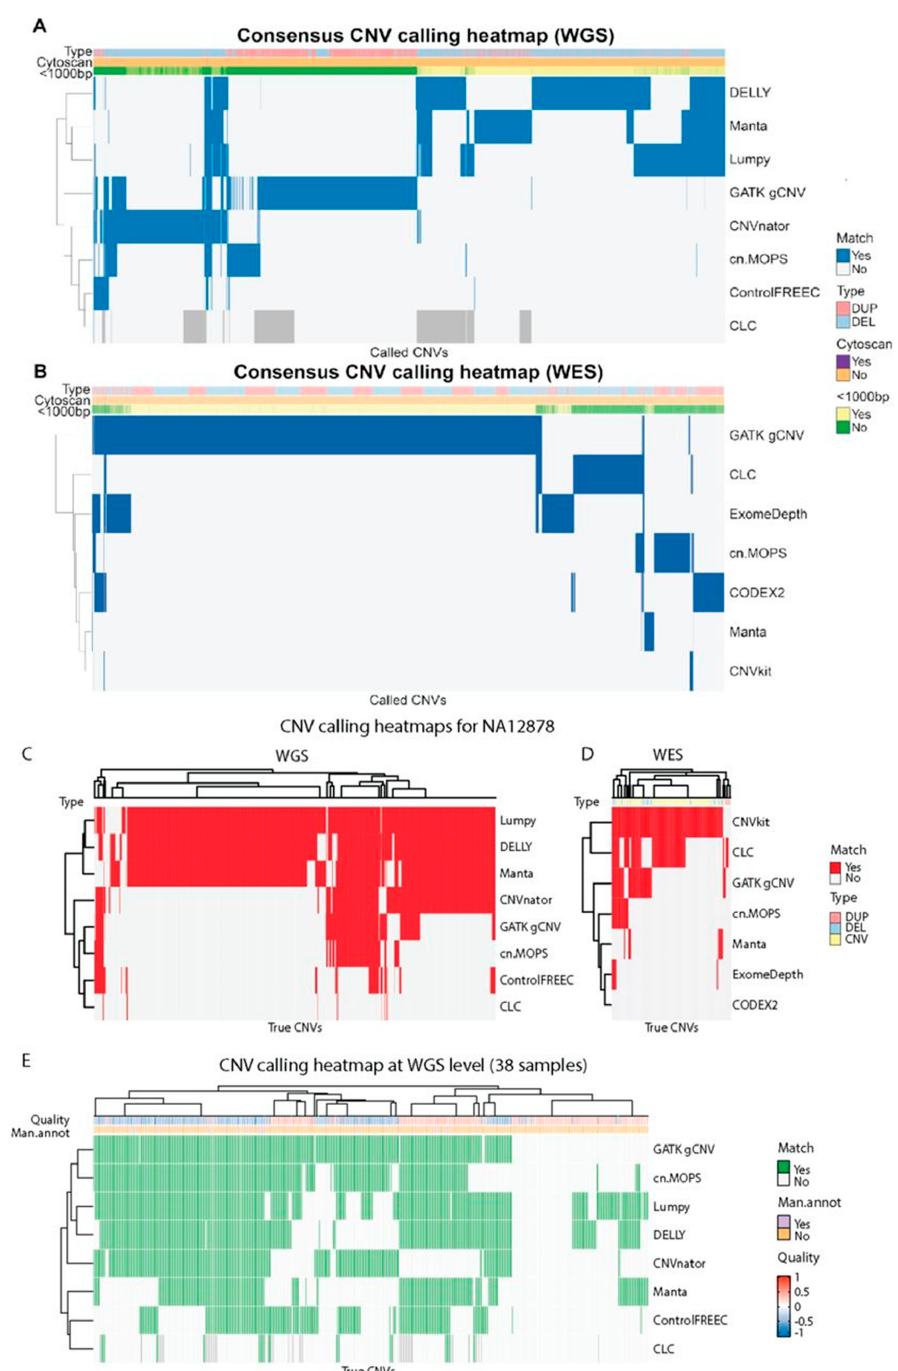
Figure 5. Heatmap showing all called CNVs across all samples ( A , B ) and called CNVs overlap with the true CNVs ( C – E ). ( A ) Whole genome sequencing (WGS; n = 407,671) and ( B ) Whole exome sequencing level (WES; n = 9944). Each row represents a tool, and a blue field denotes a call of the given CNV. All CNVs from each sample were merged across tools, such that any overlapping calls of either duplications or deletions were combined to one. Blue color denotes that the given CNV was called by the tool. The order of rows/columns for WES data and rows for WGS data was determined using complete-linkage hierarchical clustering with Euclidean distance, while the order of columns for WGS data was determined using a combination of k-means and hierarchical clustering due to memory restrictions. Darker grey coloring (WGS only) indicates that the tool was not run for the sample which contained the CNV. ( C ) 2076 WGS-based and ( D ) 81 WES-based